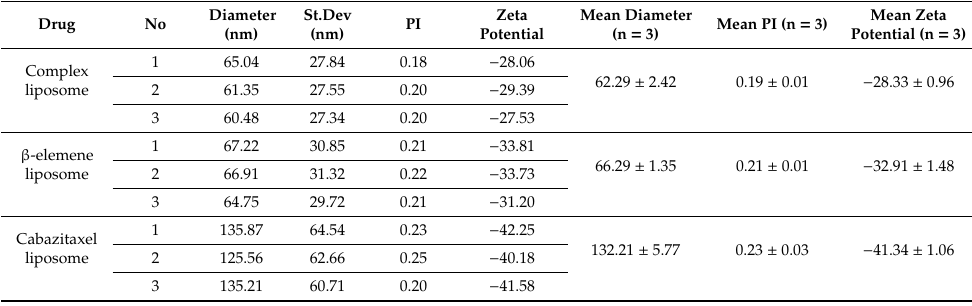
Table 3. The particle size and zeta potential of the liposomes. PI = Poydispersity